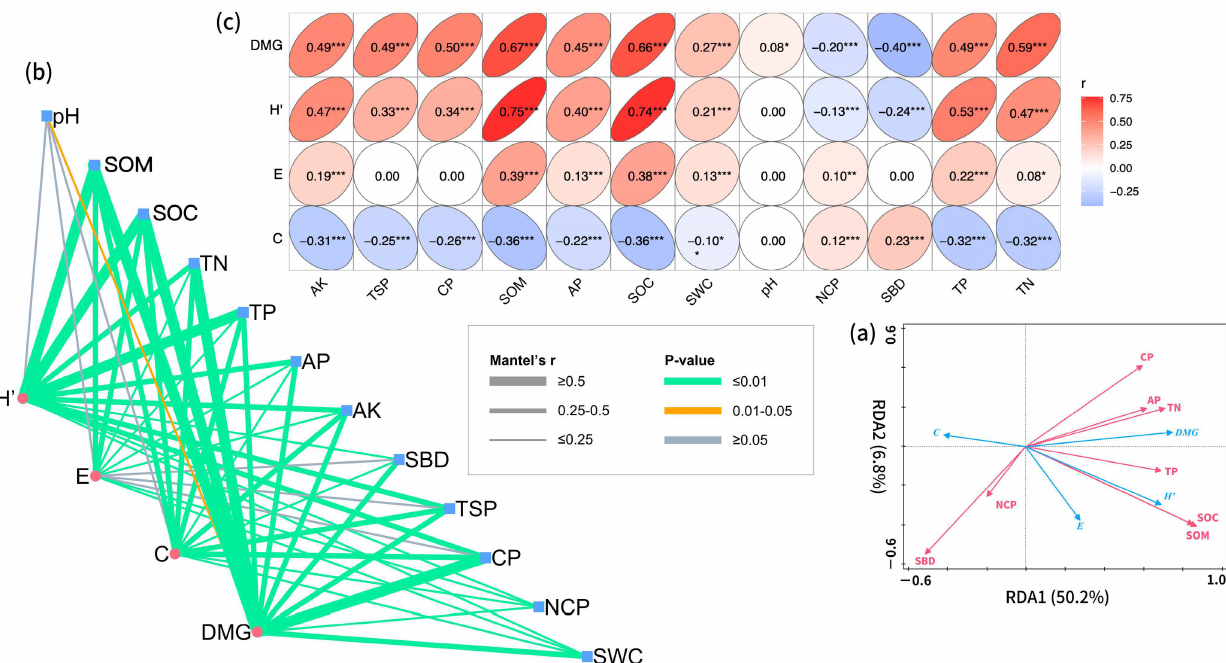
Figure 9. Plant community diversity index (autumn) and RDA ordination map of soil environmental factors. ( a ) Redundancy analysis (RDA) on soil factors and understory plant diversity; ( b ) correlation between diversity index of understory plants and soil factors in autumn; ( c ) correlation coefficient between understory plant diversity index and soil factors in autumn. Note: * correlation significant at